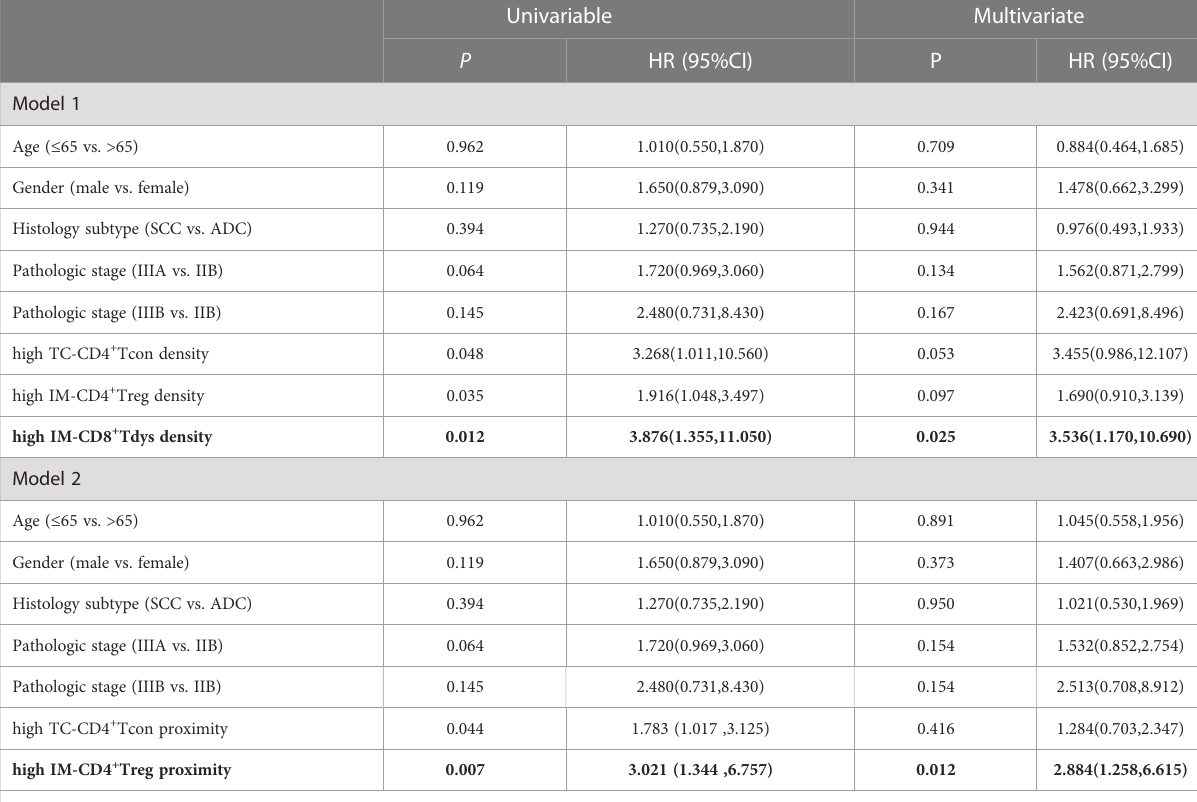
TABLE 2 Univariable and Multivariate Cox regression analysis for